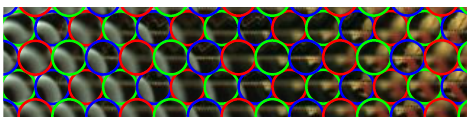
Figure 3. Section of the micro lens images (raw image) of a Raytrix camera. Different micro lens types are marked by dif- ferent